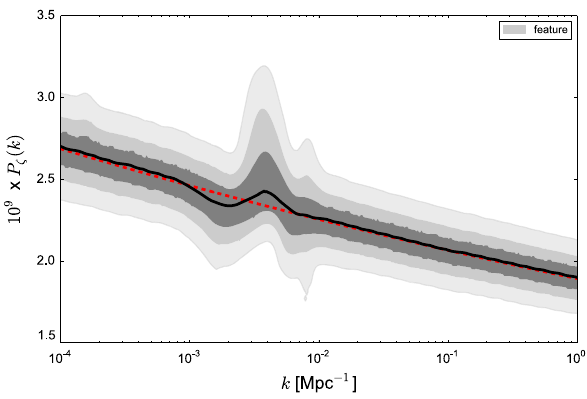
Fig. 8 The 1, 2 and 3 σ constraints obtained from observational data analysis are plotted for the primordial curvature perturbations spectrum forthemodelwithlocalfeatures.Thespectrumforthefeaturelessmodel is plotted with a red